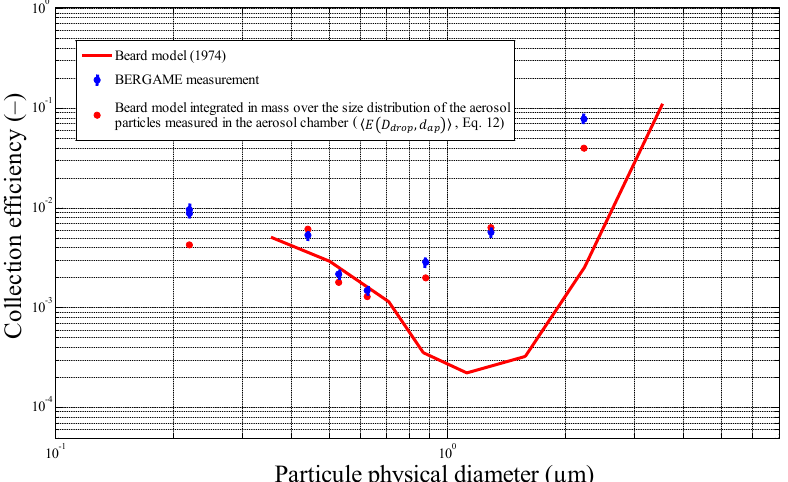
Figure 11. Integration of the Beard (1974) model over the particle size distribution of each of our experiments for a drop of 1.25mm diameter.